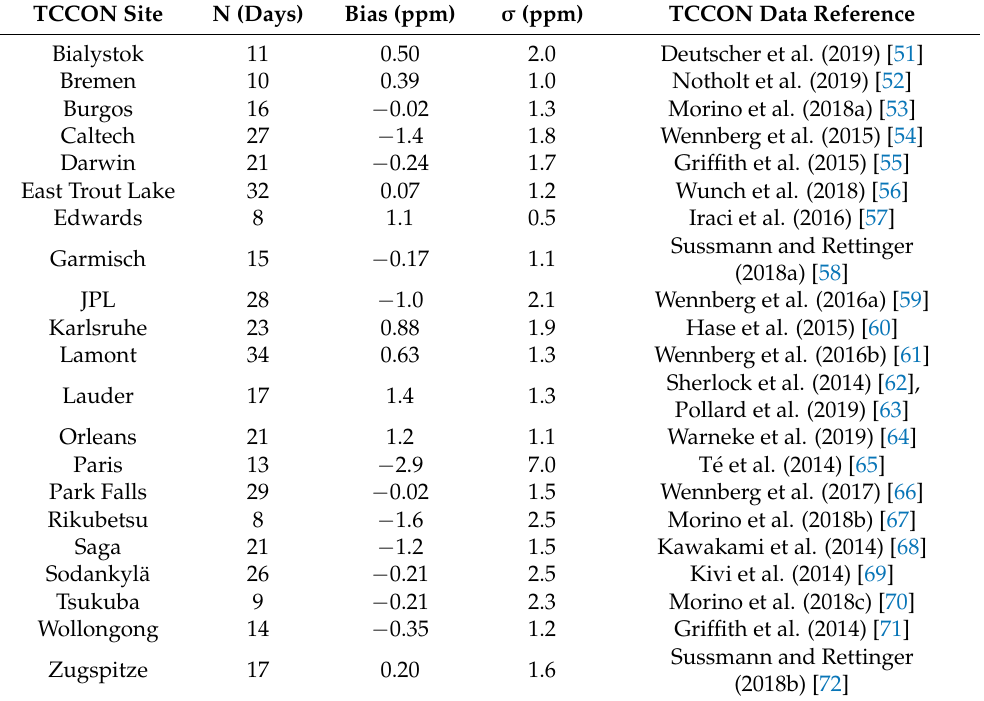
Table 4. Evaluation of TanSat OCFP XCO 2 at the TCCON sites globally. The results have been calculated from daily median XCO 2 values. Bias is here determined as ∆ XCO 2 = XCO 2 (TanSat) − XCO 2 (TCCON).